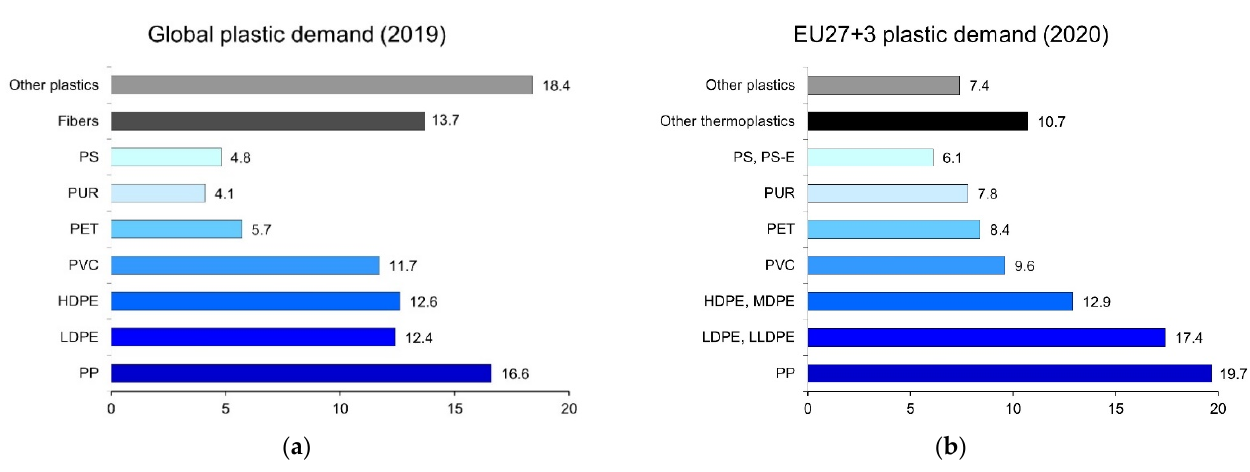
Figure 4. Distribution of plastic demand globally ( a ) and in EU27+3 ( b ) by polymer types. The figure is created according to the data from OECD [1] and PlasticsEurope [3].